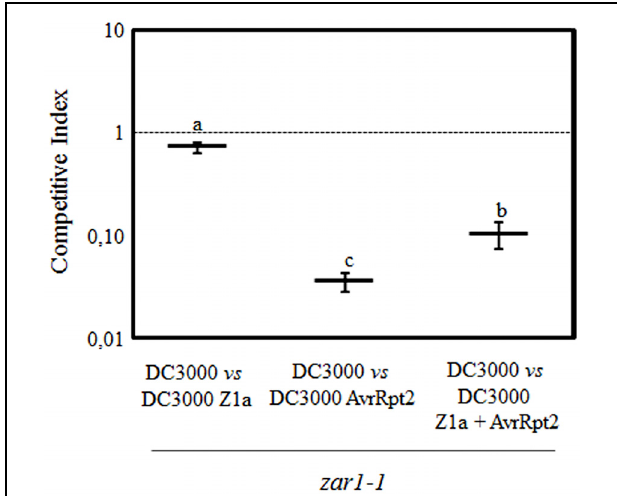
FIGURE 3 | HopZ1a suppresses AvrRpt2-triggered ETI in zar1-1 plants. Competitive indices (CIs) measuring growth within a mixed infection of DC3000 expressing HopZ1a (Z1a, pAME30), AvrRpt2 (pAME8) or co-expressing both (Z1a + AvrRpt2, pAME33) in relation to growth